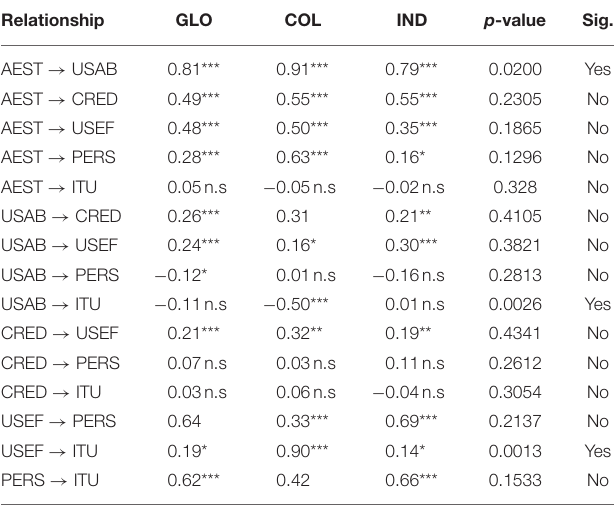
TABLE 4 | Multigroup analysis showing how collectivist and individualist cultures significantly differ. Relationship GLO COL IND p -value